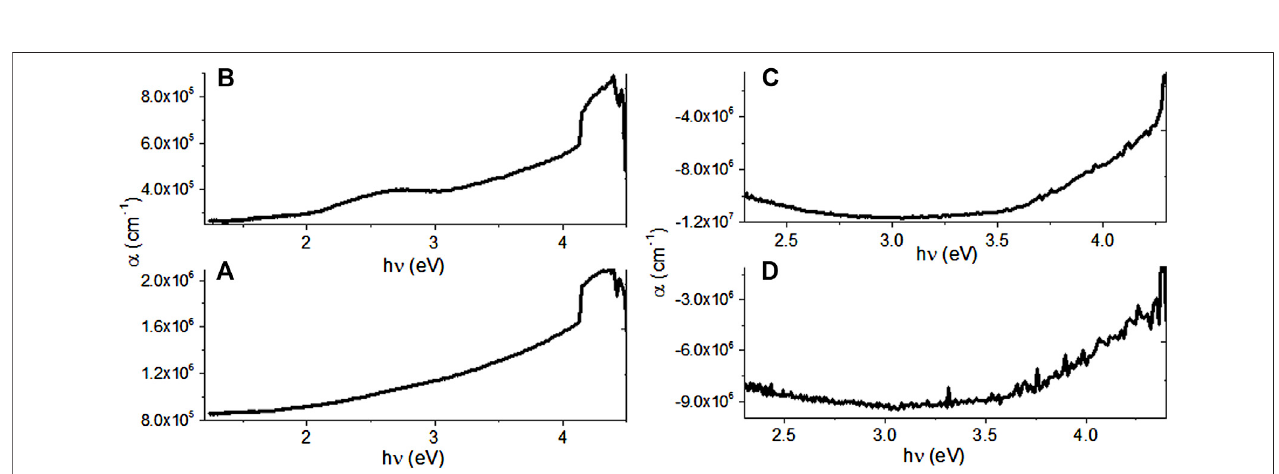
FIGURE 6 | Variation of α with h ] for (A) PEDOT:PSS-graphene- a complex, (B) PEDOT:PSS-graphene- b complex, (C) PEDOT:PSS- a complex, and (D) PEDOT: PSS- b complex fi lms.